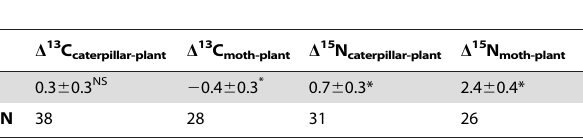
Values are mean 6 95% confidence intervals. Values labeled with NS are those for which the confidence interval overlaps with 0, whereas those labeled with * are those for which the 95% confidence interval for the mean does not include